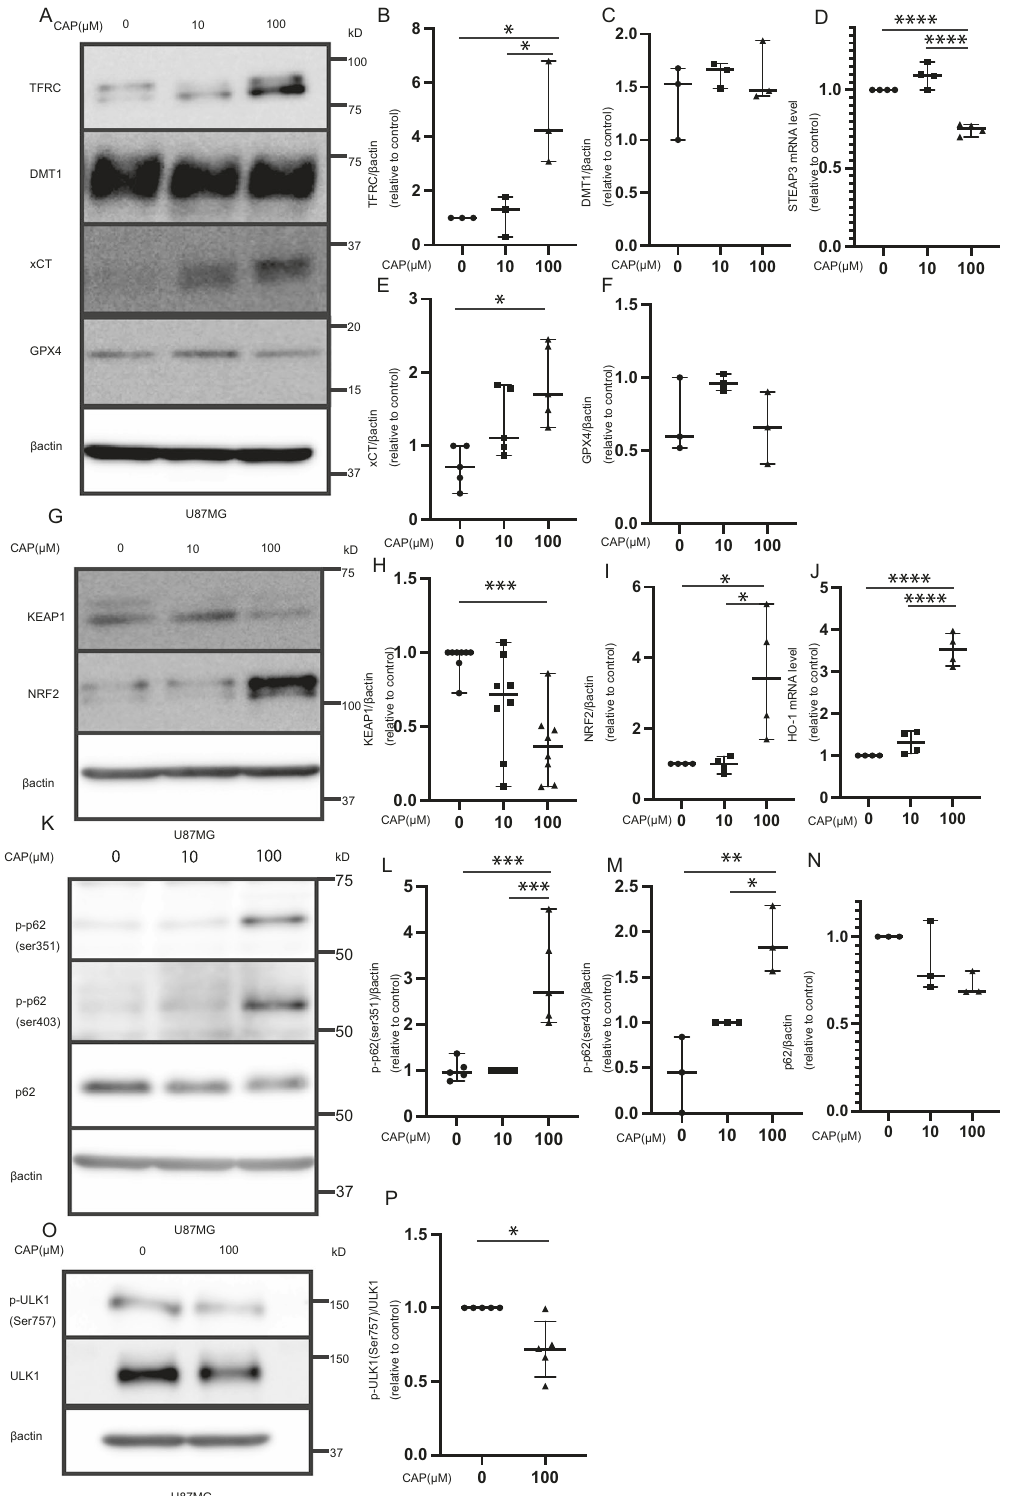
Fig. 3 KEAP 1-NRF 2-HO-1 pathways are activated. A change in ferroptosis was observed after CAP treatment for 3 days in U87. A Western blot revealed that the TFRC level ( N = 3) was changed, but the DMT1 ( N = 3), xCT ( N = 5), and GPX4 ( N = 3) levels were not changed after CAP treatment and ( B , C , E , F ) quanti fi cation results. D Quanti fi cation of STEAP3 mRNA expression ( N = 4). G Western blot revealed that the KEAP1 ( N = 7) and NRF2 ( N = 4) levels were changed and H , I quanti fi cation results. J Quanti fi cation of HO-1 mRNA expression ( N = 4). K After CAP treatment, western blotting of p-p62 ser 351, 403, and p62 was performed and L – N p-p62 ser 351 ( N = 5), 403 ( N = 3), and p62 ( N = 3) were quanti fi ed. O Western blot revealed that the p-ULK1 (Ser757) were changed and P quanti fi cation results ( N = 5). Values are presented as mean ± SD. Student ’ s t test ( P ) or ordinary one-way ANOVA with Tukey ’ s multiple comparisons test ( B – F , H – J , L – N ) was performed on control vs. CAP 10 μ M and control vs. CAP 100 μ M. * p < 0.05, *** p < 0.001, **** p <